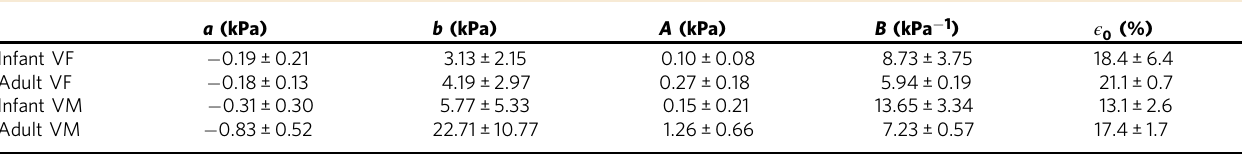
(cid:1) a þ b ϵ ; ϵ (cid:2) ϵ 0 Ae B ϵ ; ϵ > ϵ 0